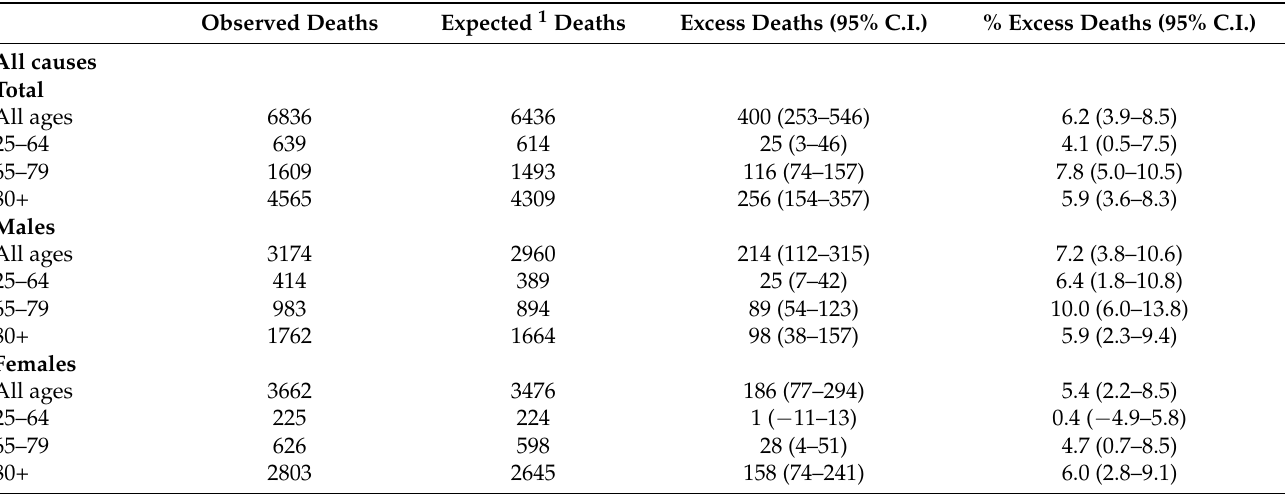
Table 2. Number of observed and expected deaths, along with the excess mortality estimates in 2021, for all causes, at all ages and three age groups, in the total, males and females population. Pavia province, Lombardy region, Italy.